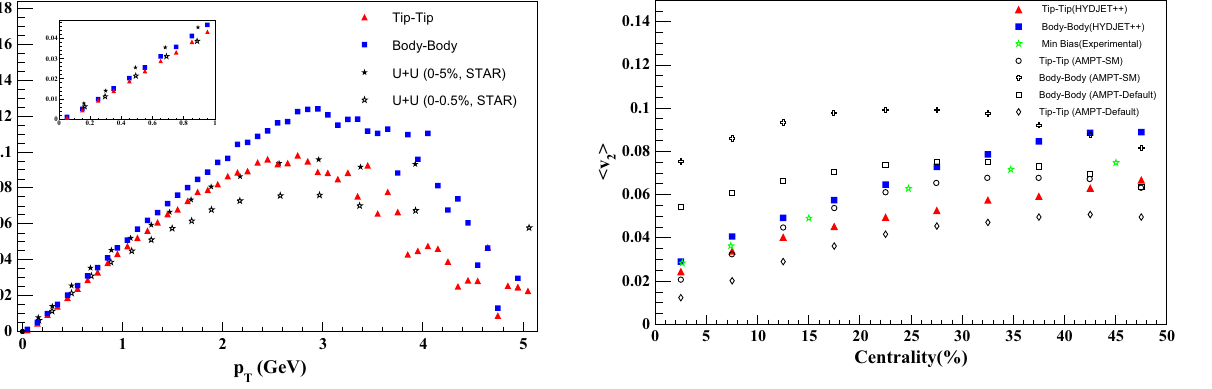
Fig. 25 Comparisonof v 2 ofchargedhadronswithrespecttocentrality in body–body and tip–tip configuration. Green stars are experimental data taken from Ref. [14] and AMPT model data is taken from Ref.